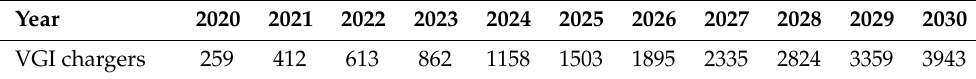
Table 3. The number of chargers participating in VGI